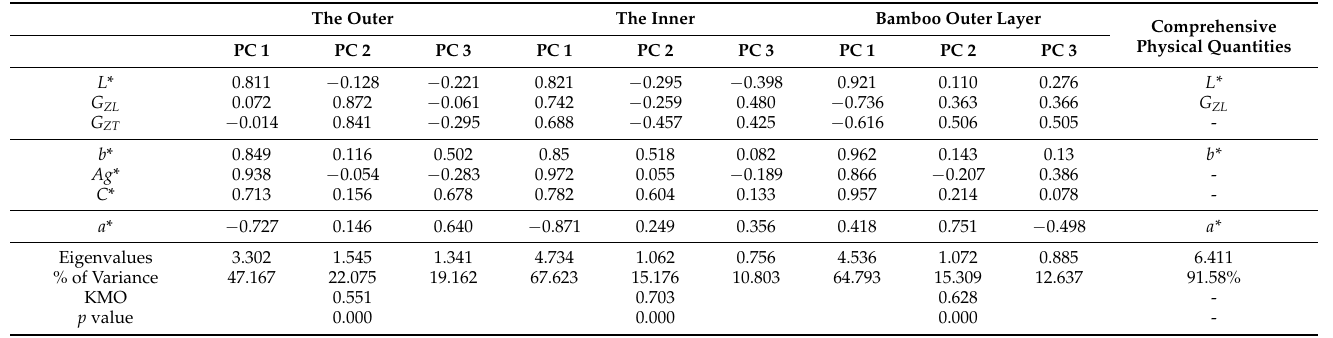
Table 6. Principal component analysis of seven visual physical quantities. - indicates no